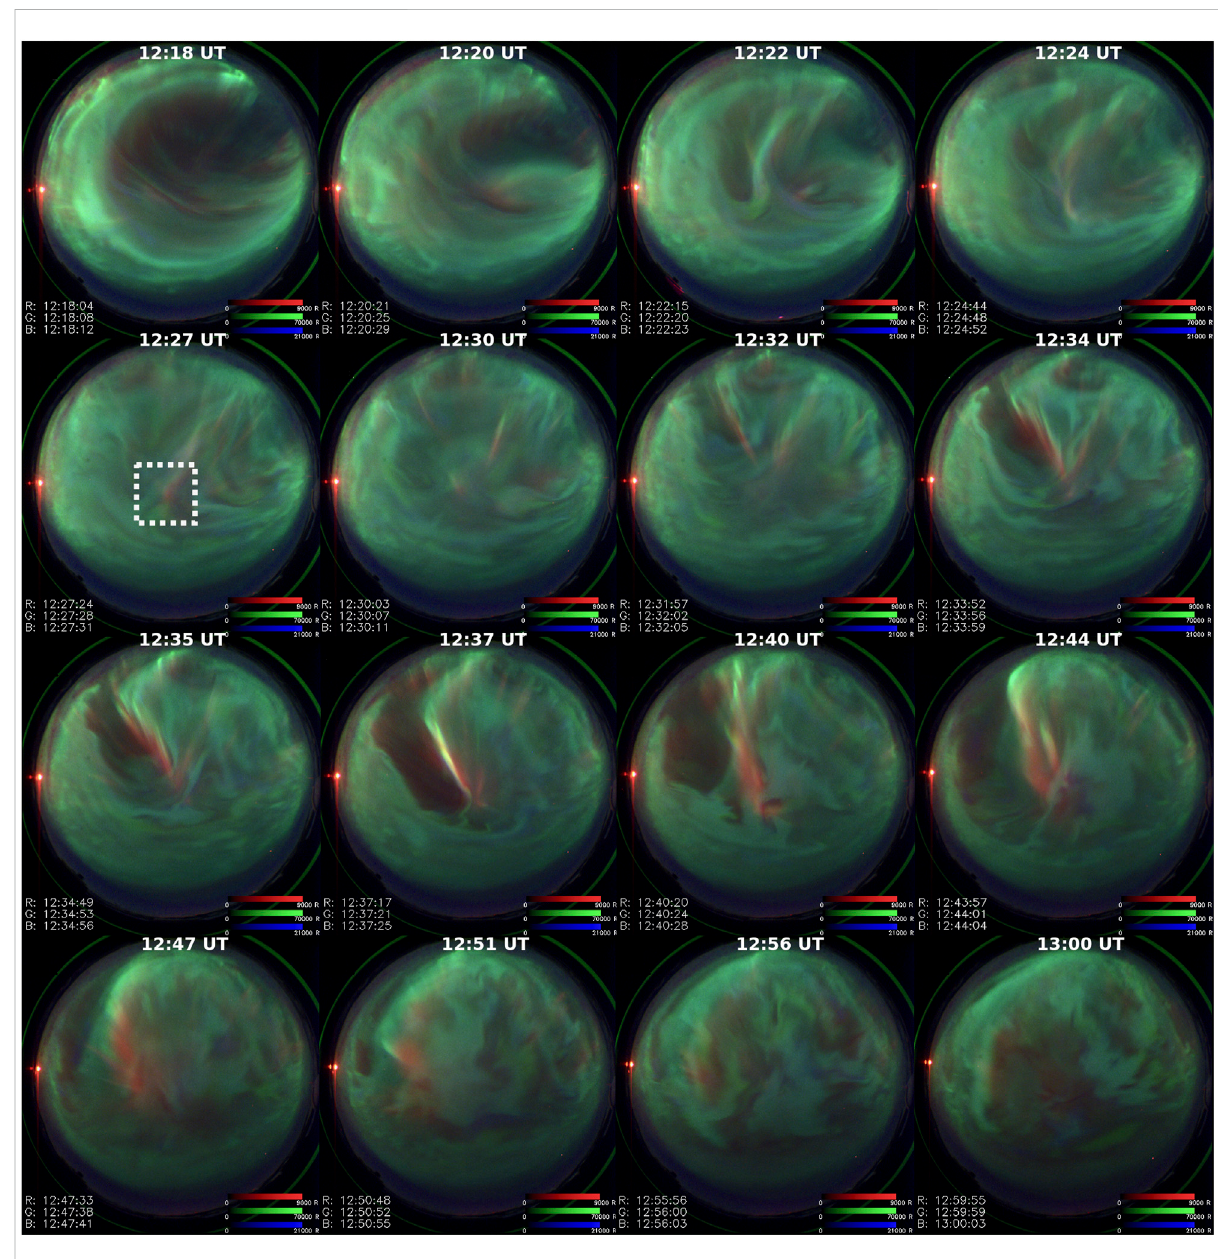
FIGURE 4 Composite (red, green, blue) All Sky Imager frames from the Poker Flat EMCCD. Selected images are not regularly sampled from available data butaremeantto depicttheevolutionoftheauroraduring theevent.Inall frames,NorthisupandEastisright.Thewhite, dottedsquare indicatesthe location of magnetic zenith (center of the square), which is the same in all